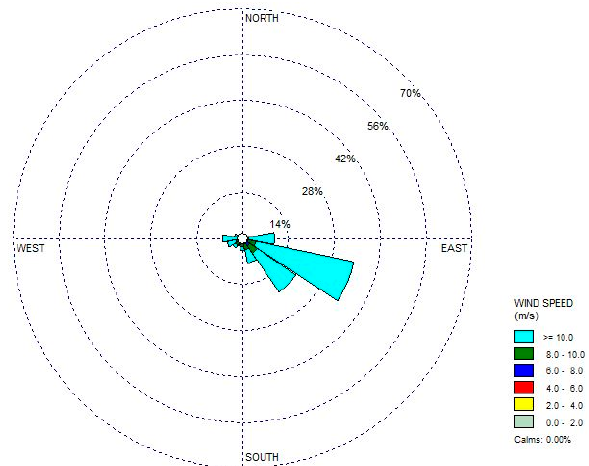
Figure 2. Windrose in Prigi Bay.